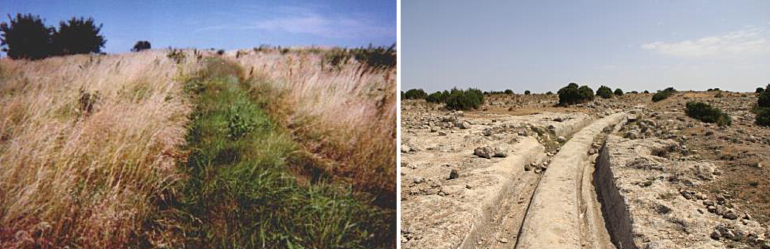
Figure 4. (Left) The Mormon Trail through south-central Iowa, USA. This trail was used by wagon traffic from about 1846 to 1853, but the effects of that traffic are still detectible in the trail’s soils. Here the trail appears as a zone of reduced vegetative productivity in this August photograph (Brevik and Fenton, 2012). (Right) A 2300-year-old cart trail at Castellar de Meca in eastern Spain. Traffic from the carts led to the complete removal of the soil at this location. Photo by Artemi